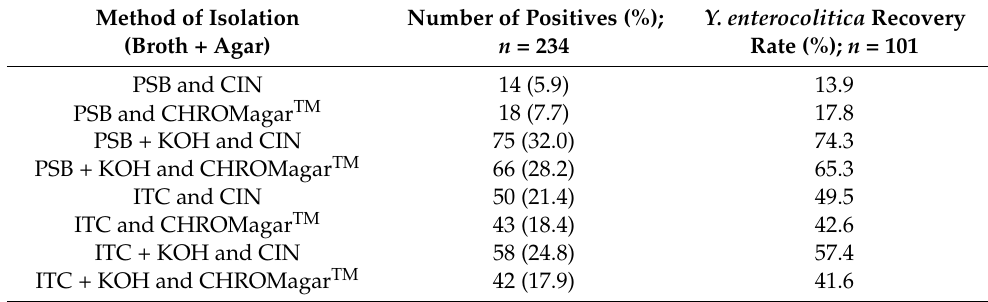
Table 3. Comparison of different methods regarding recovery rate and isolation of Y. enterocolitica from pig tonsils.